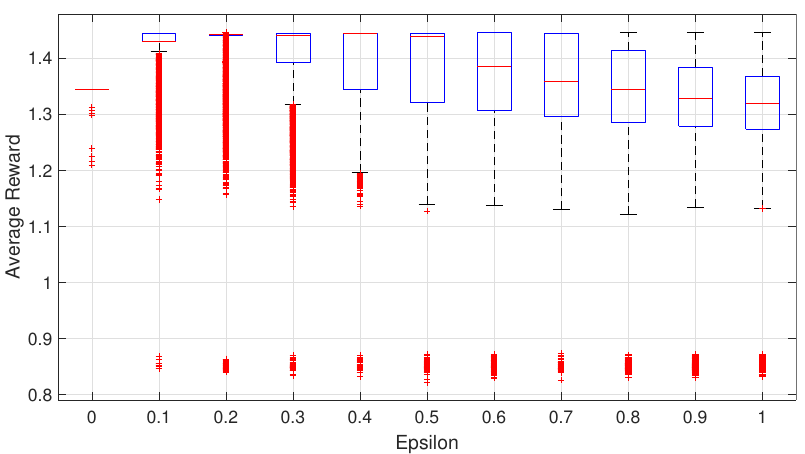
Figure 10. Average reward for different epsilon values.